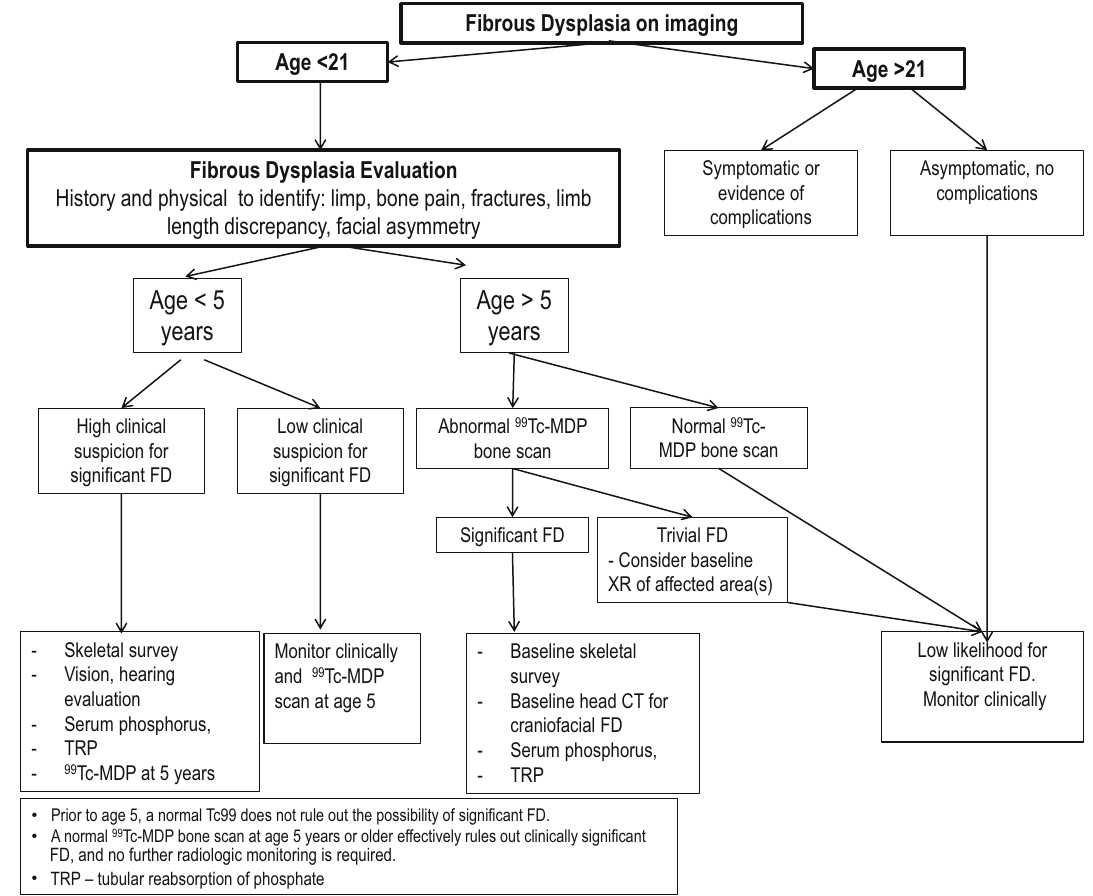
Fig. 30 An algorithm of the management of fibrous